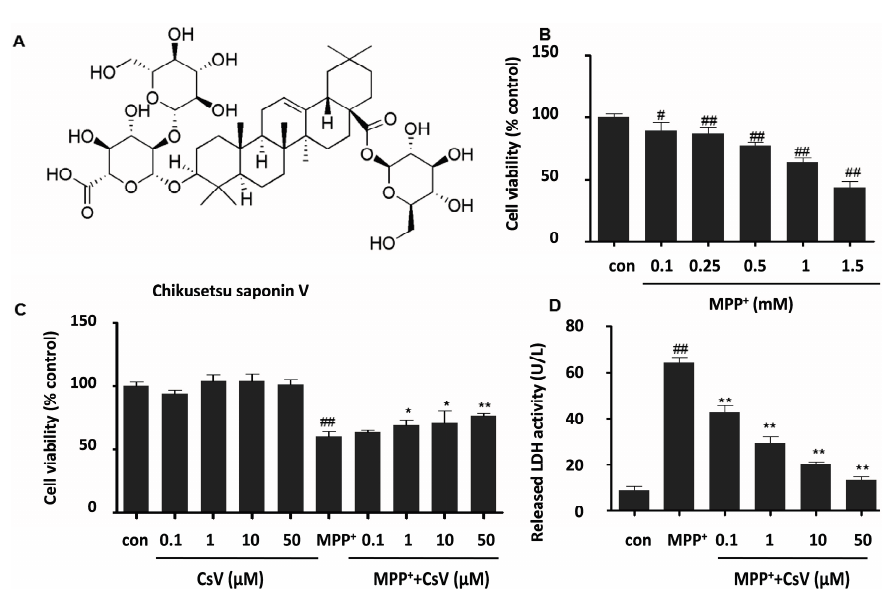
Figure 1. Protective effects of Chikusetsu saponin V (CsV) on 1-methyl-4-phenylpyridinium ion (MPP + )-induced cytotoxicity in SH-SY5Y cells. ( A ) Chemical structure of CsV; ( B ) Dose-dependent effects of MPP + on cell viability in SH-SY5Y cells; ( C ) Effects of CsV on MPP + -induced cytotoxicity in SH-SY5Y cells as assessed by MTT assay; and ( D ) Effects of CsV on MPP + -induced cytotoxicity in SH-SY5Y cells as shown by Lactate dehydrogenase (LDH ) assay. Data are expressed as means ± SD ( n = 5). # p < 0.05, ## p < 0.01 vs. control group, * p < 0.05, ** p < 0.01 vs. the group treated with MPP +